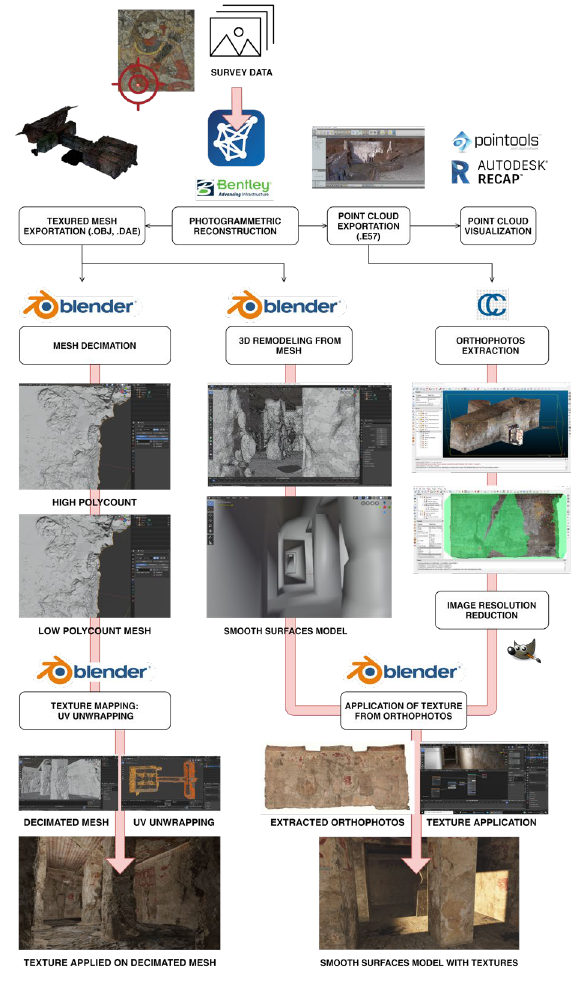
Figure 8 . The method implemented for the 3D reconstruction of a previous state of existence of TT96A’s geometry and mesh